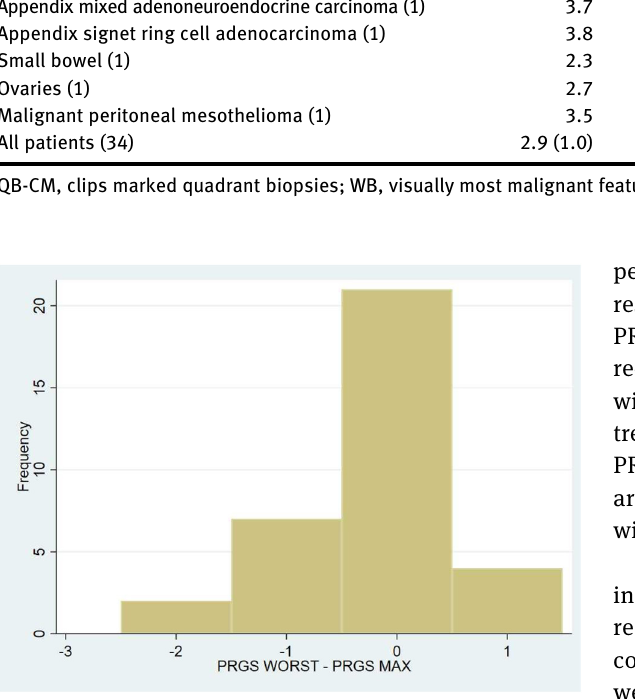
Colorectal adenocarcinoma (  )